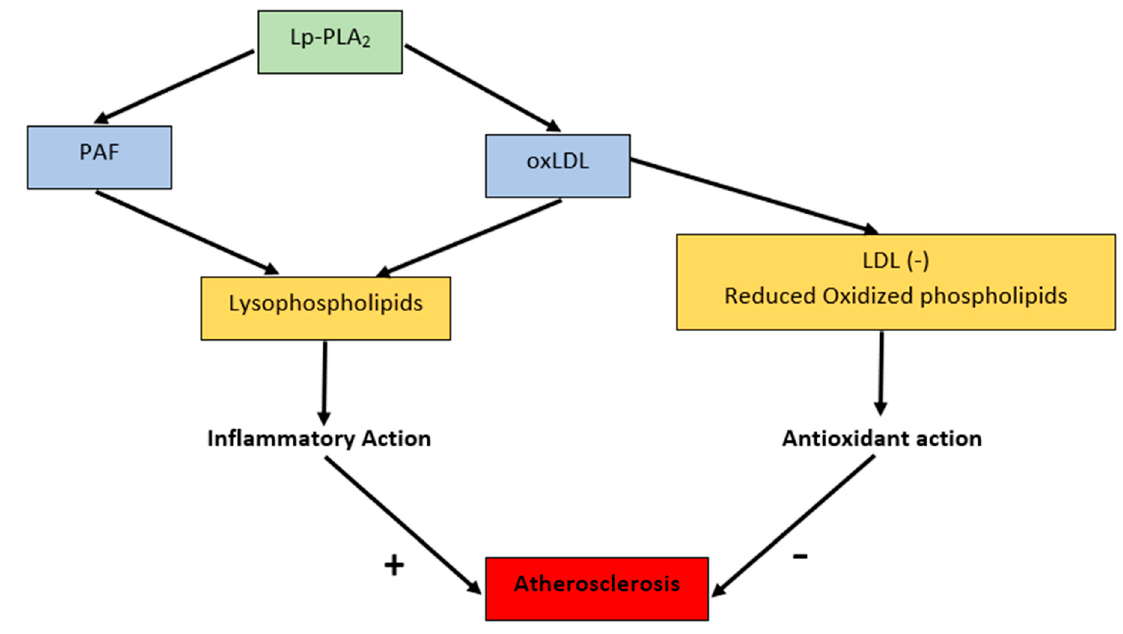
Figure 2. Role of PAF in atherosclerosis [29].